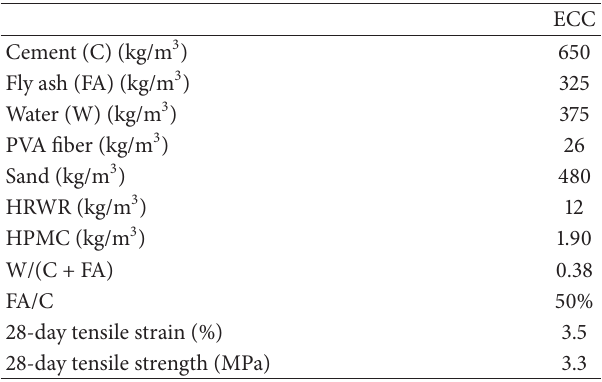
Table 1: Mixture properties of ECC.